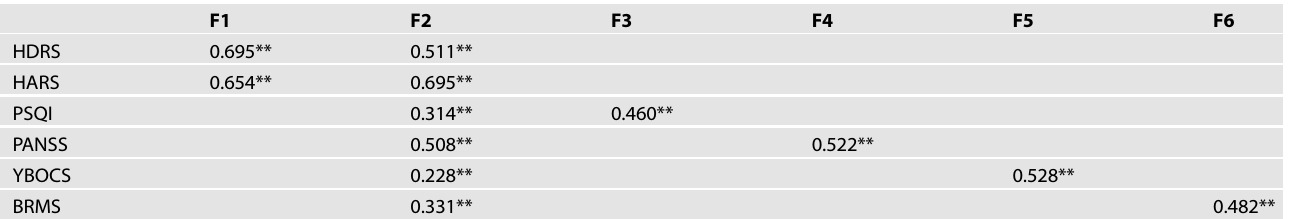
Table 3. Criterion validity of factors in